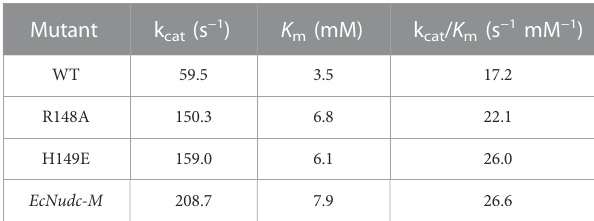
TABLE 1 The kinetic parameter of WT and mutants toward